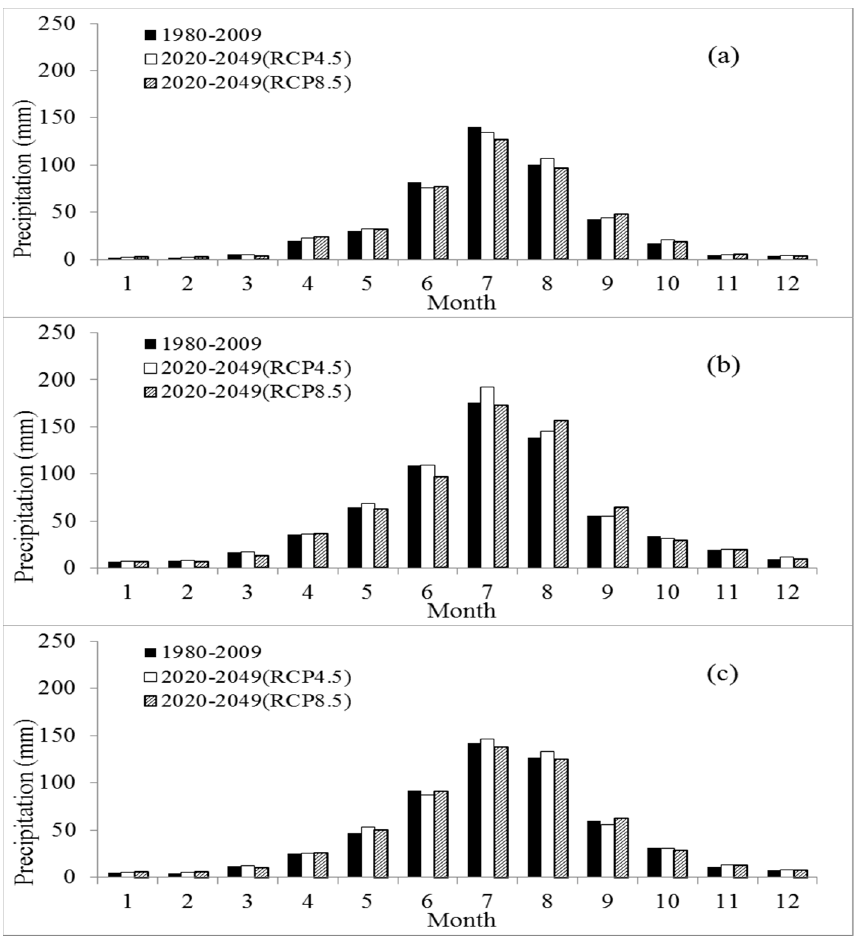
Figure 5. Changes of average monthly precipitation in the Nenjiang River ( a ); Upper Songhua River ( b ); and Lower Songhua River ( c ) sub ‐ basins of the Songhua River Basin.